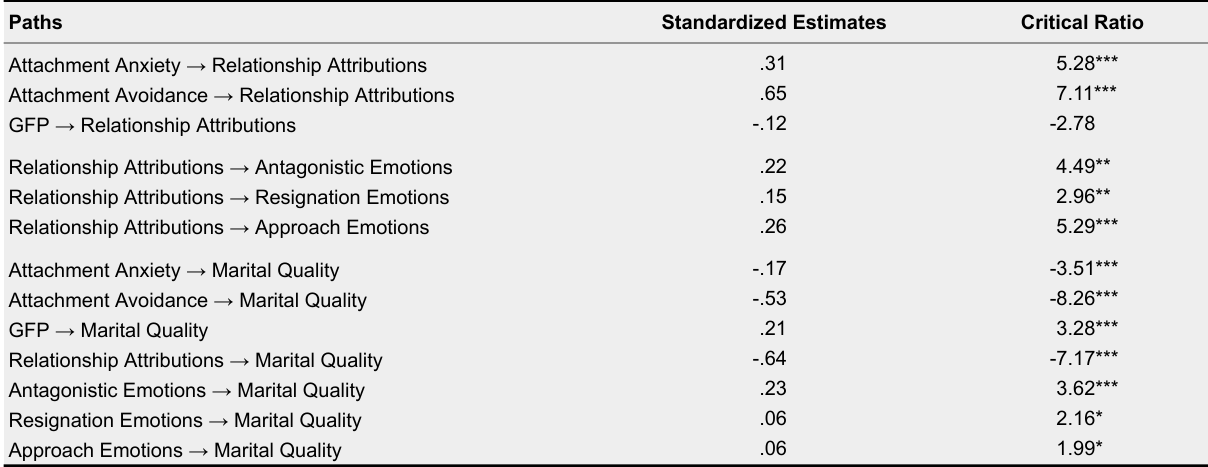
Standardized Estimates of the Paths for the Hypothesized Relationships Between Attachment Dimensions, GFP, Relationship Attributions, Emotional Reactions, and Marital